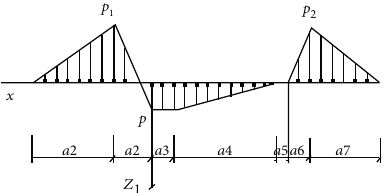
Figure 3: Distribution diagram of additional stress in the fl oor after mining at the W coal